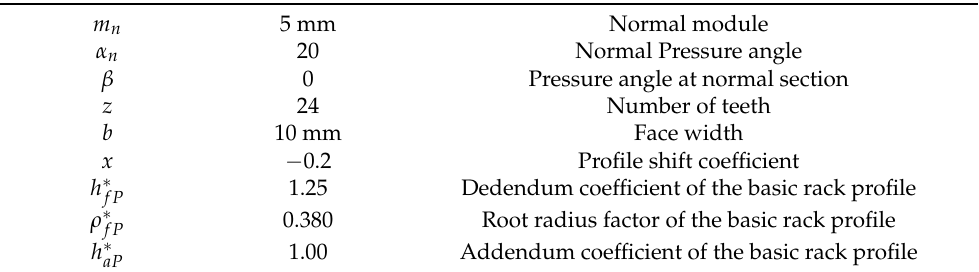
Table 1. Gear main data.